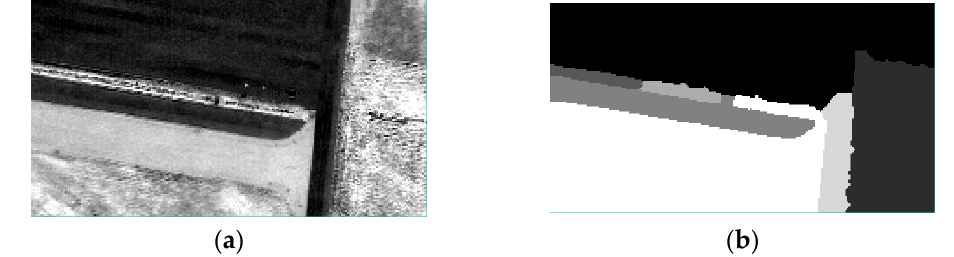
Figure 7. Metal plate data set. ( a ) Radiance domain image and ( b ) segmentation map.